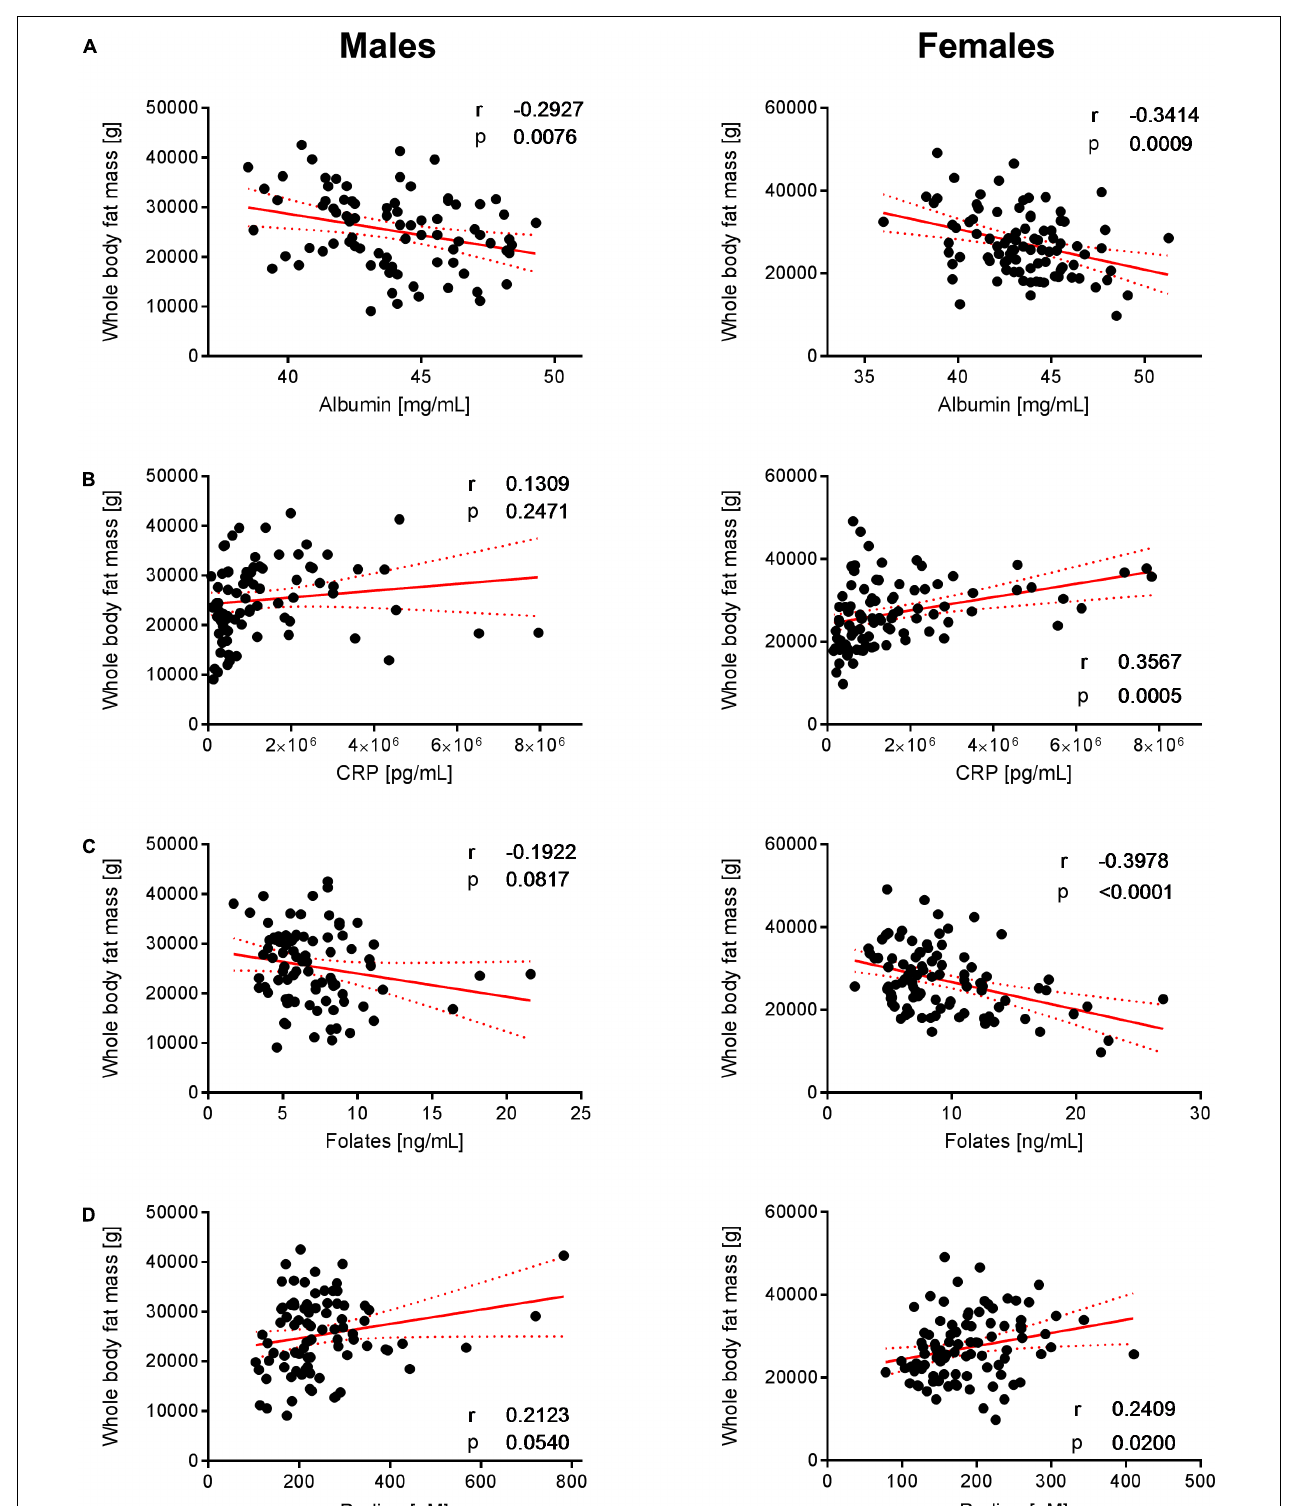
FIGURE 6 | Correlation of albumin, CRP, folates, and proline with whole-body fat mass. The data set showed significant correlations of (A) albumin, (B) CRP, (C) folates, and (D) proline with whole-body fat mass in females but not in males (with the exception of albumin that exhibits a negative correlation with whole-body fat mass in both sexes). Pearson’s correlations (r) as well as two-tailed p -value are shown. N = 83 (males) and N = 93 (females). Each dot represents an individual sample. Red dotted lines show the 95% confidence interval.